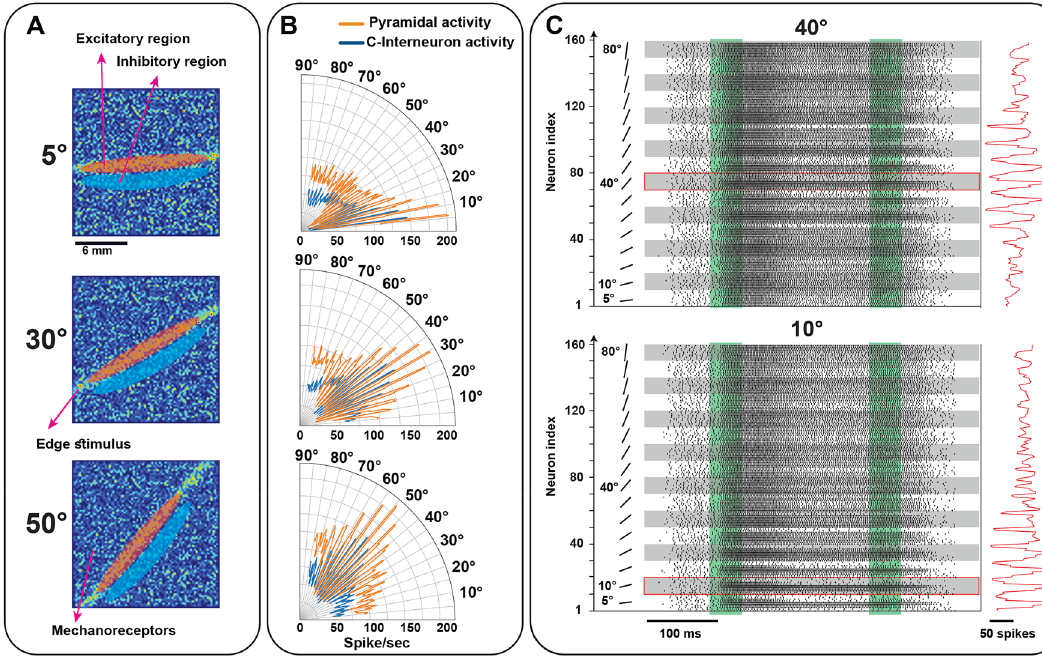
Figure 9. The cortical neuron receptive fields with excitatory and inhibitory sub-regions on the skin. ( A , B ) Receptive fields of cortical neurons are located at different positions across the skin and neurons selectively respond to the orientation stimulus. Activation of excitation areas on the skin increases the cortical firing, on the other hand, activation of inhibitory areas leads to a decrease in the spontaneous firing. ( C ). The firing response of 160 orientation-sensitive neurons in area 3b to 10° and 40° indented edge stimuli. Each group of the ten neurons is sensitive to one orientation which location of their receptive fields on the skin is different. The green areas show the onset and end phases of